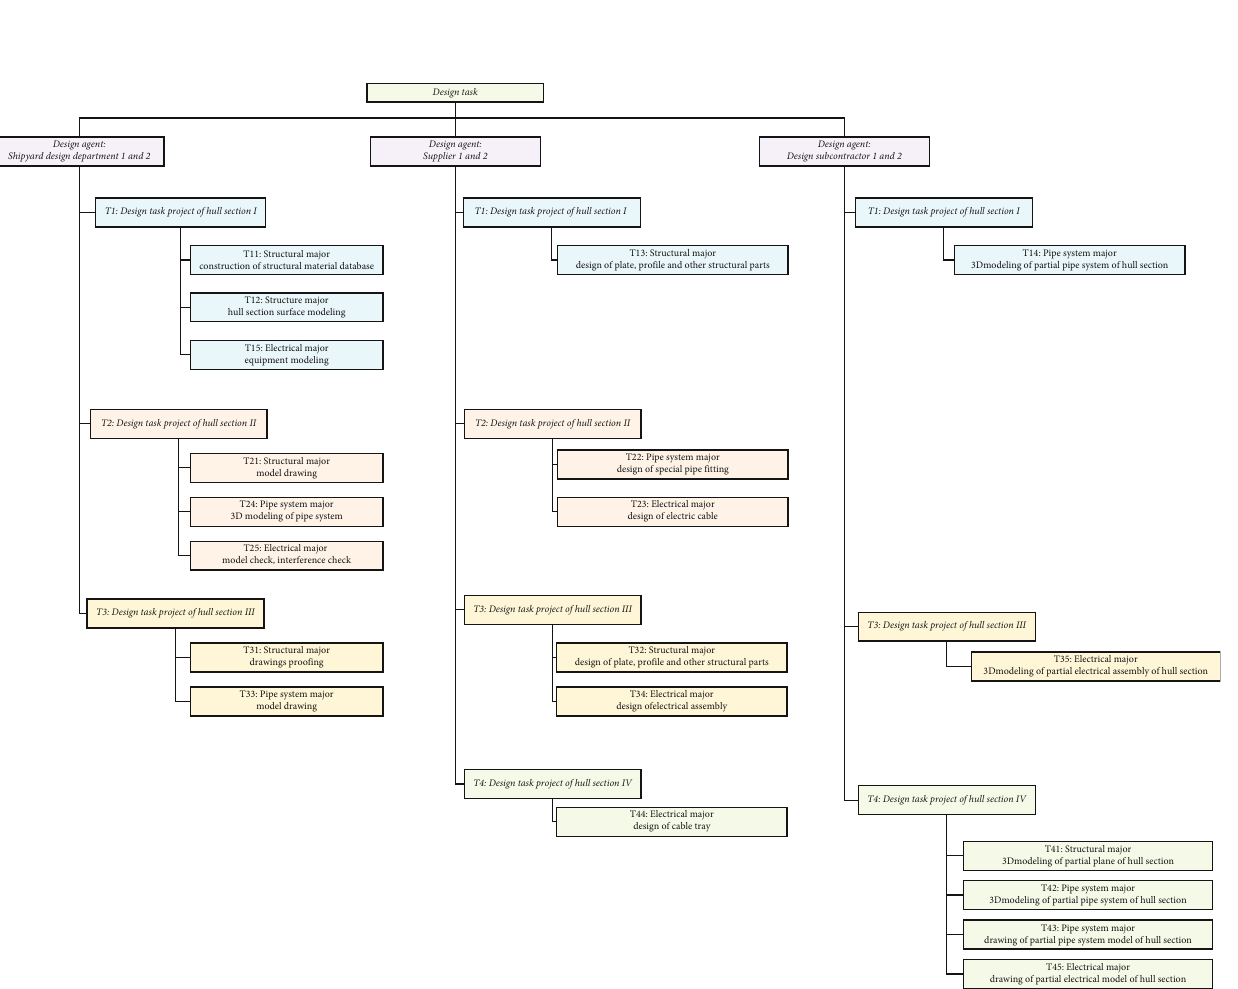
Figure 2: Task item decomposition and speci fi c contents of subtasks. Table 8: Design task-number of rated